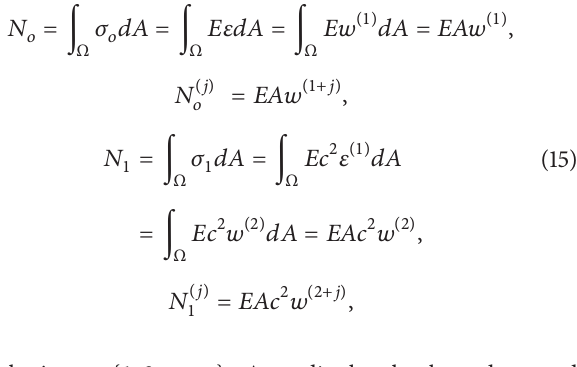
Figure 1: Rod under constant axial